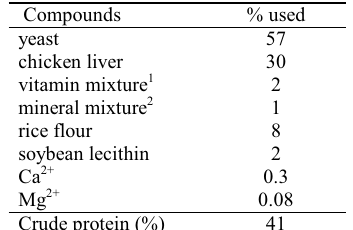
Table 1. Composition of the ground dry pellets used to feed silver catfish larvae. 1 - Content (kg): vit. A : 75000 UI; vit. D3:15.000; vit E: 300 mg; vit K3: 25 mg; vit B1: 75 mg; vit B2: 150 mg; vit B6: 75 mg; vit B12: 250 mg; biotine: 12.5 mg; pantotenic acid: 250 mg; folic acid: 25 mg; nicotinic acid:: 875 mg; choline: 10 g; vit C: 250 mg; inositol: 4 g. 2 - Content (kg): Mg 2+ : 50 mg.L -1 ; S: 400 mg.L -1 ; Mn: 40 mg.L -1 ; Cu: 0.3 mg.L -1 ; Fe: 7.5 mg.L -1 ; Zn: 7 mg.L -1 ; Co: 0.7 mg.L -1 ; I: 20 mg.L -1